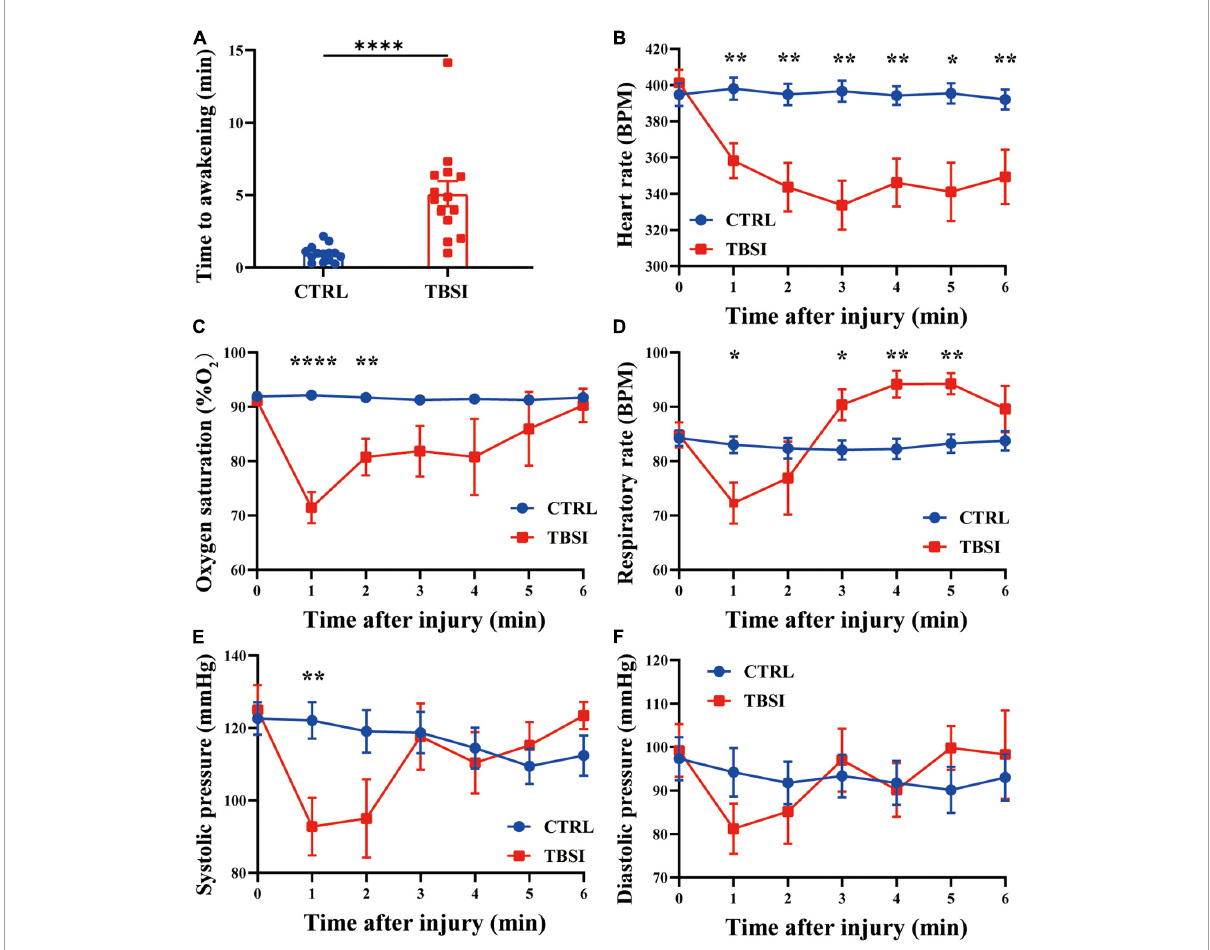
FIGURE1 Stress response. (A) Time to awakening. (B) Heart rate. (C) Percutaneous arterial oxygen saturation. (D) Respiratory rate. (E) Systolic pressure. (F) Diastolic pressure. Results are mean ± SEM of 14 rats in each group. T -tests, * P < 0.05, ** P < 0.01, **** P <